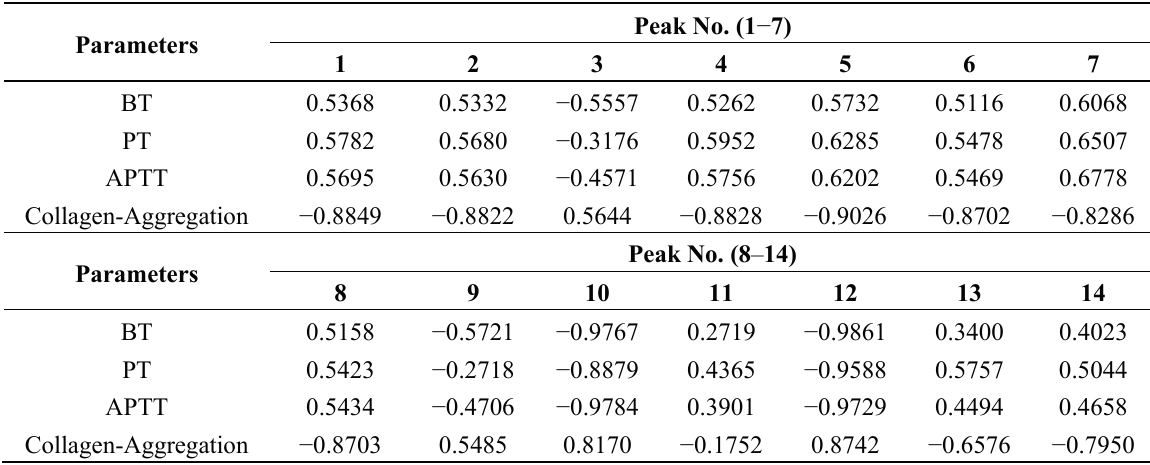
Table 4. Correlation coefficients between chromatograms peaks and main hemostatic parameters.